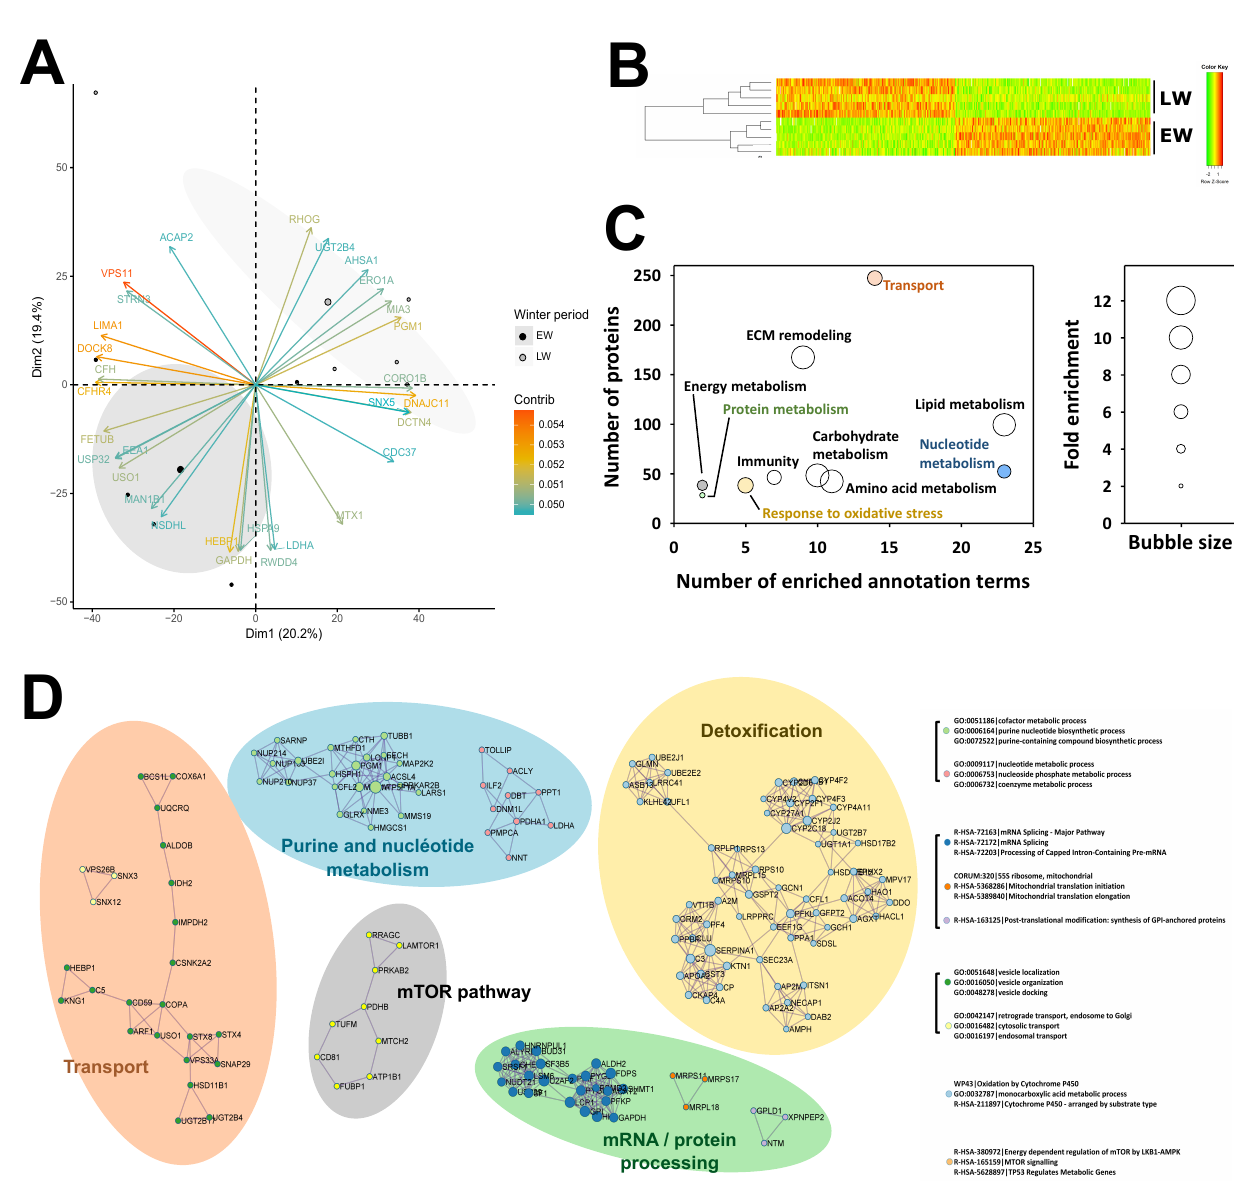
Figure 2. Overview of liver proteomics data. Principal component analysis performed from expres- sion levels of all 4522 proteins analyzed using mass spectrometry (panel A ; the 30 most contributing proteins are represented) and hierarchical clustering performed from expression levels of all 538 proteins found differentially expressed between early (EW) and late (LW) winter (panel B ) allowed these two conditions to be well discriminated. Functional annotation analysis performed from the list of the 538 differential proteins revealed enriched ontology terms, which allowed the determination of broad functions significantly affected between EW and LW. Complementary “functional information” was obtained using the algorithm from Ease/DAVID (panel C ) and that from Metascape (panel D ). Colors in (panels C , D ) indicate overlapping information. Detailed protein abundances and fold changes are given in Table S1. ECM: extracellular